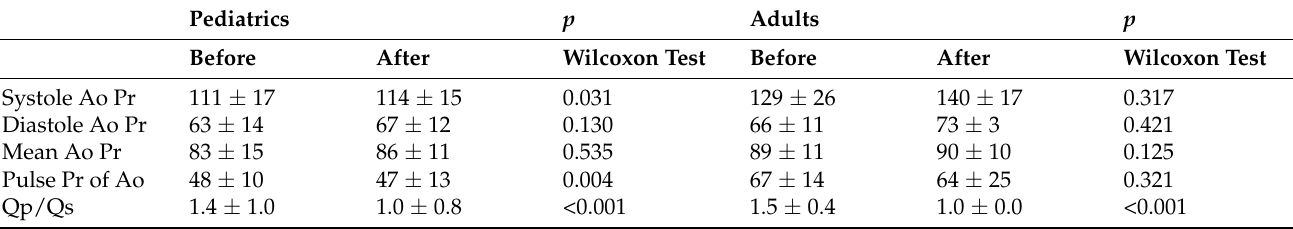
Table 4. The pressure differences before and after PDA occlusion using NOC in